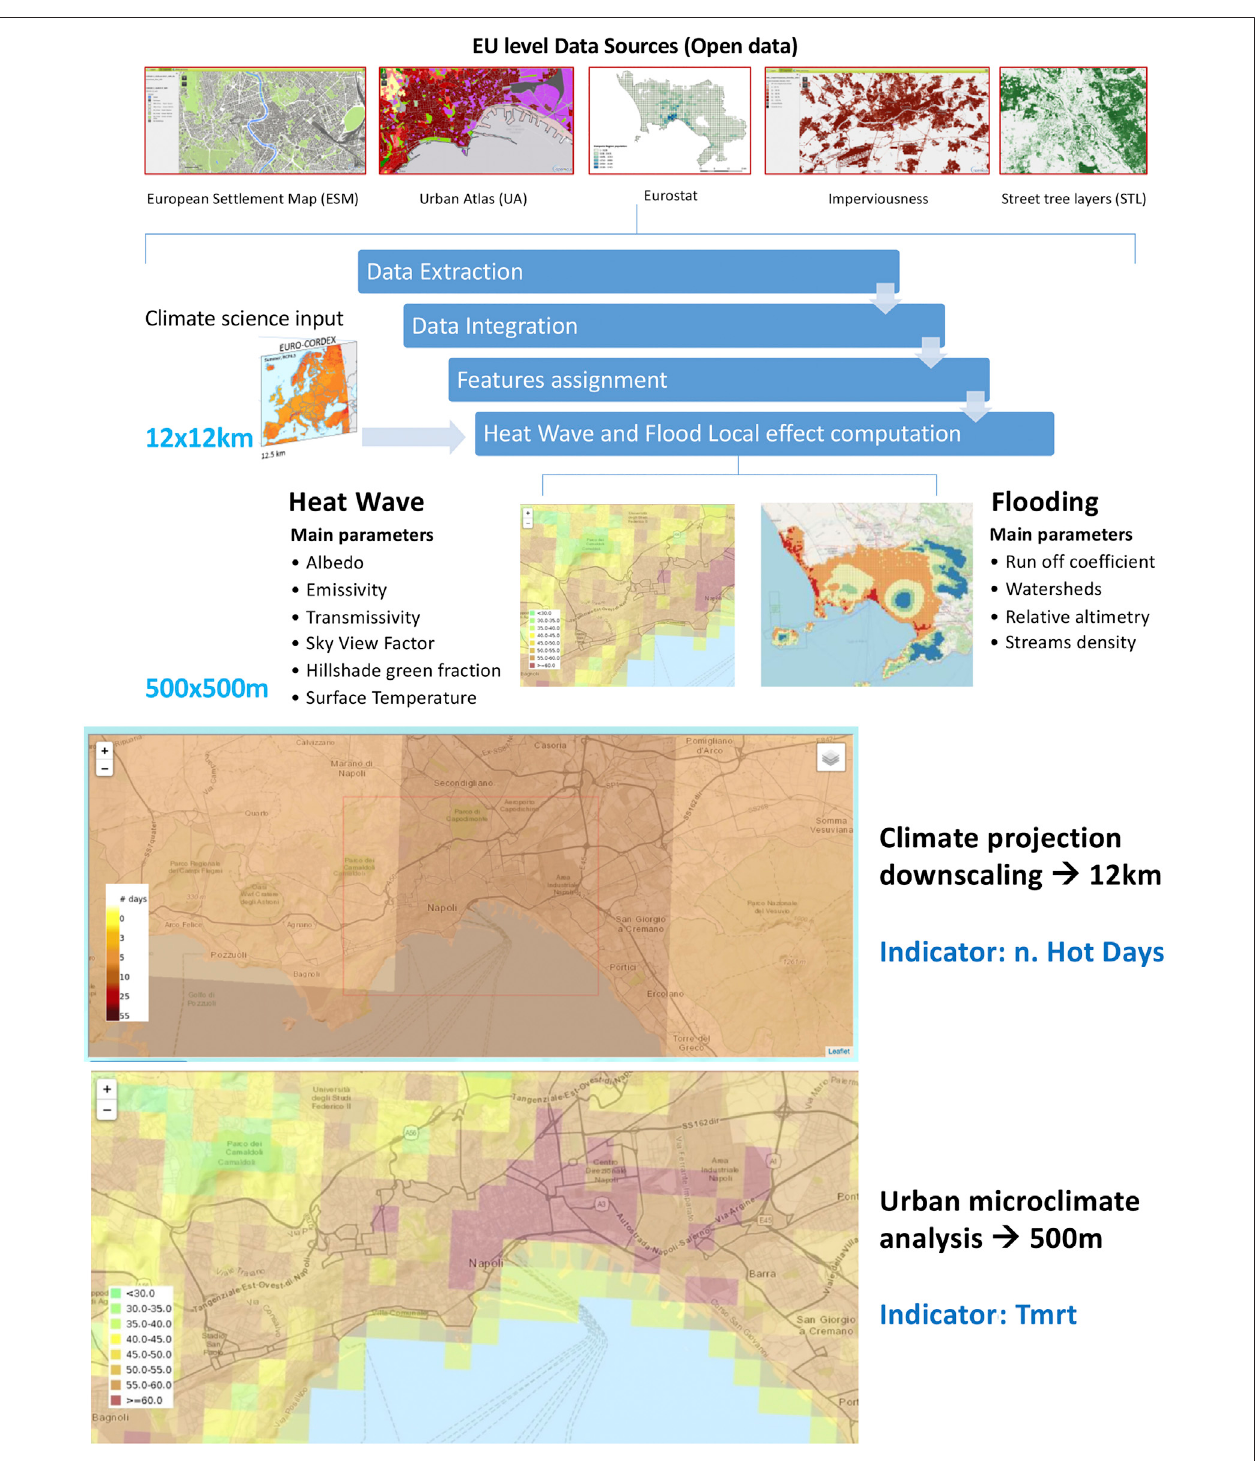
FIGURE 1 | CLARITY CSIS approach to determine parameters affecting heat and fl ood hazard at urban level (top) ; difference in resolution of projections from Regional Climate Models and CSIS urban microclimate analysis.